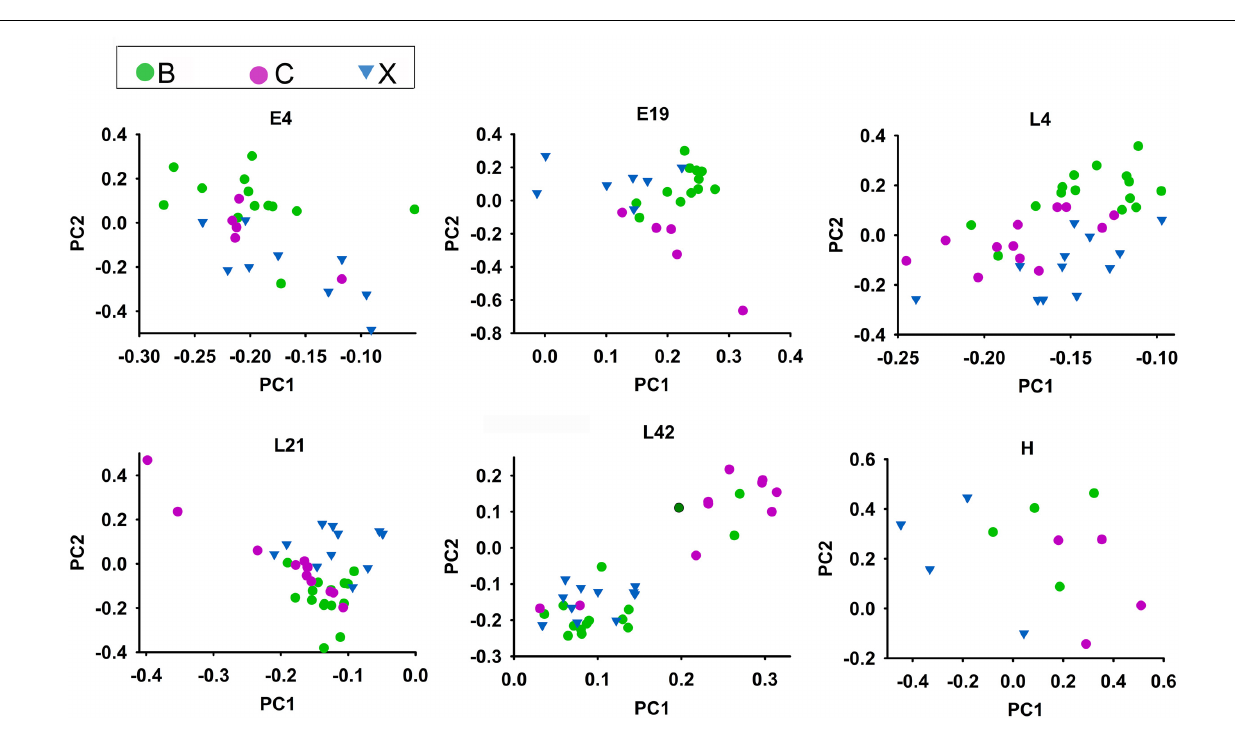
FIGURE 5 | Microbiota compositions for Beijing Fatty (B), Shiqiza (C), and Xianju (X) of chickens within different host development stages including embryos (E) E4 and E19; chicks (L) at 4 (L4), 21 (L21), and 42 days (L42) post hatch; and maternal hens